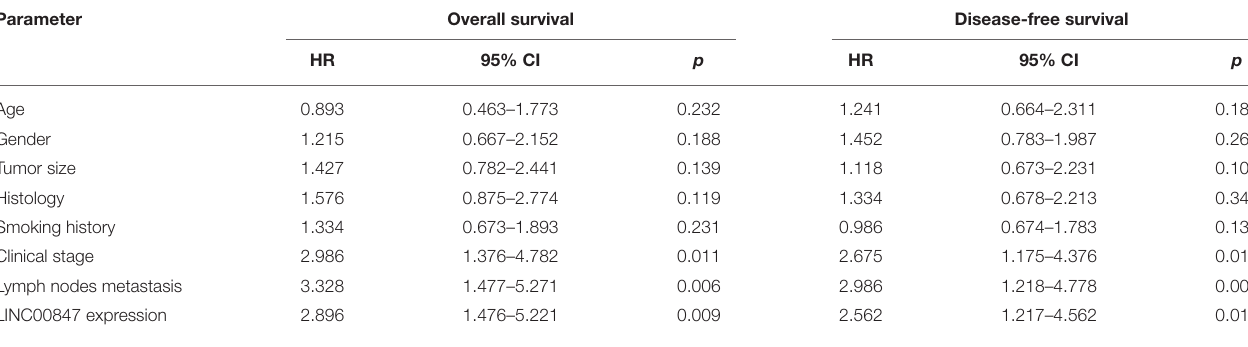
TABLE 3 | Summary of multivariate Cox regression analyses of overall survival and disease-free survival duration.